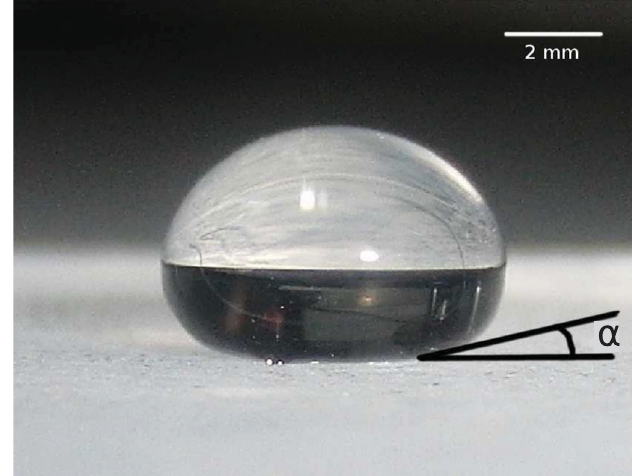
Fig. 8. Drop laying on a superhydrophobic surface (candle soot and shoe waterproo fi ng product on a PMMA plate). The contact angle (180 ° (cid:3) a ) is approximately 160 °